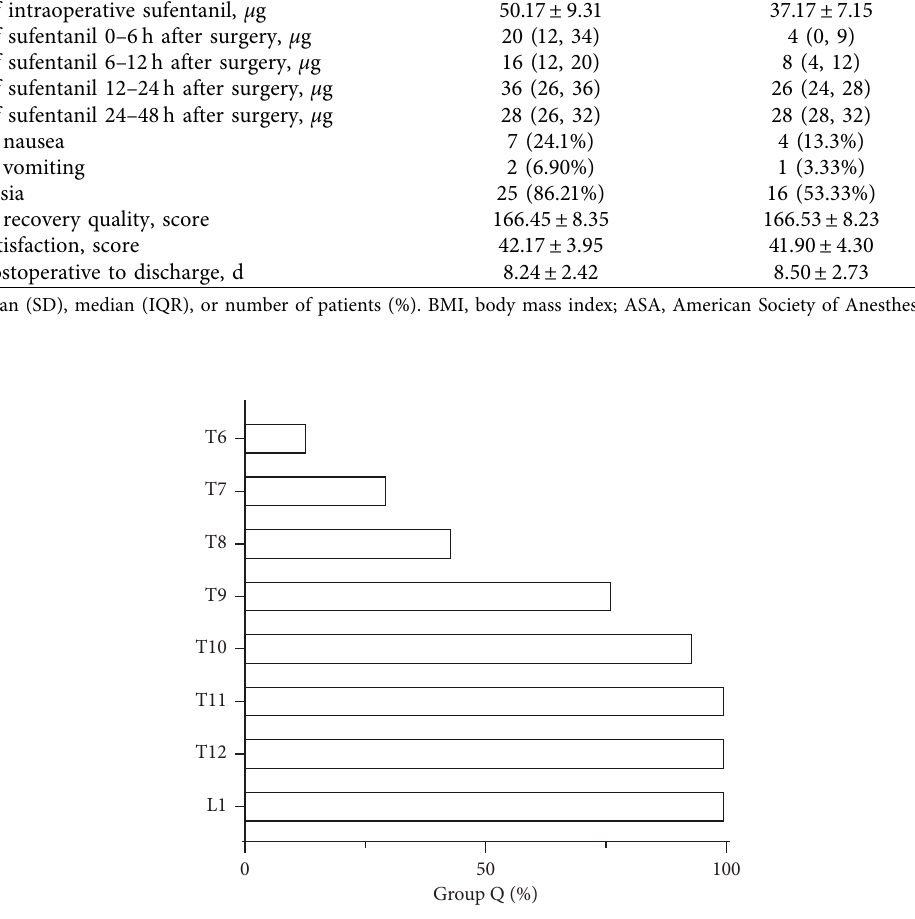
Figure 4: Te extent of dermatomal coverage in group